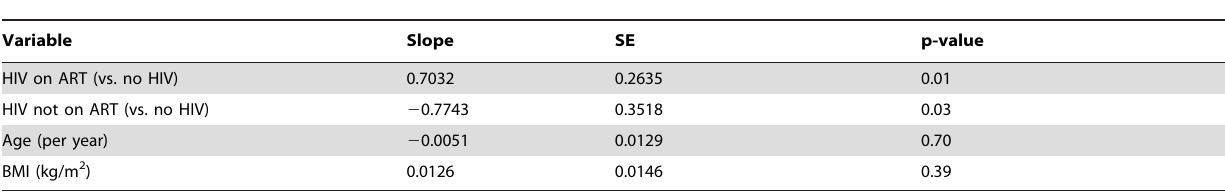
Table 3. Multiple Linear Regression Model for BAL Glutathione.